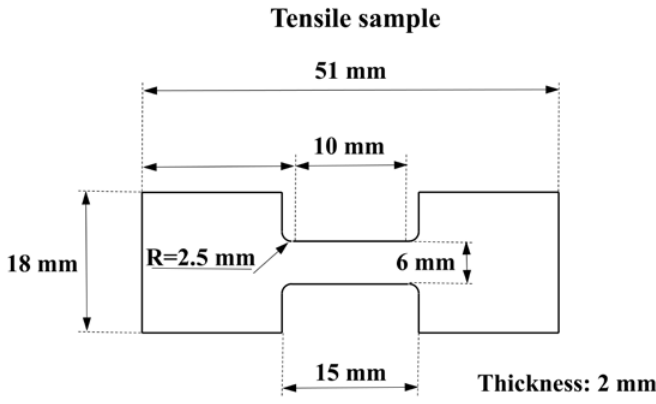
Figure 2. The specific shape and size of the tensile sample.